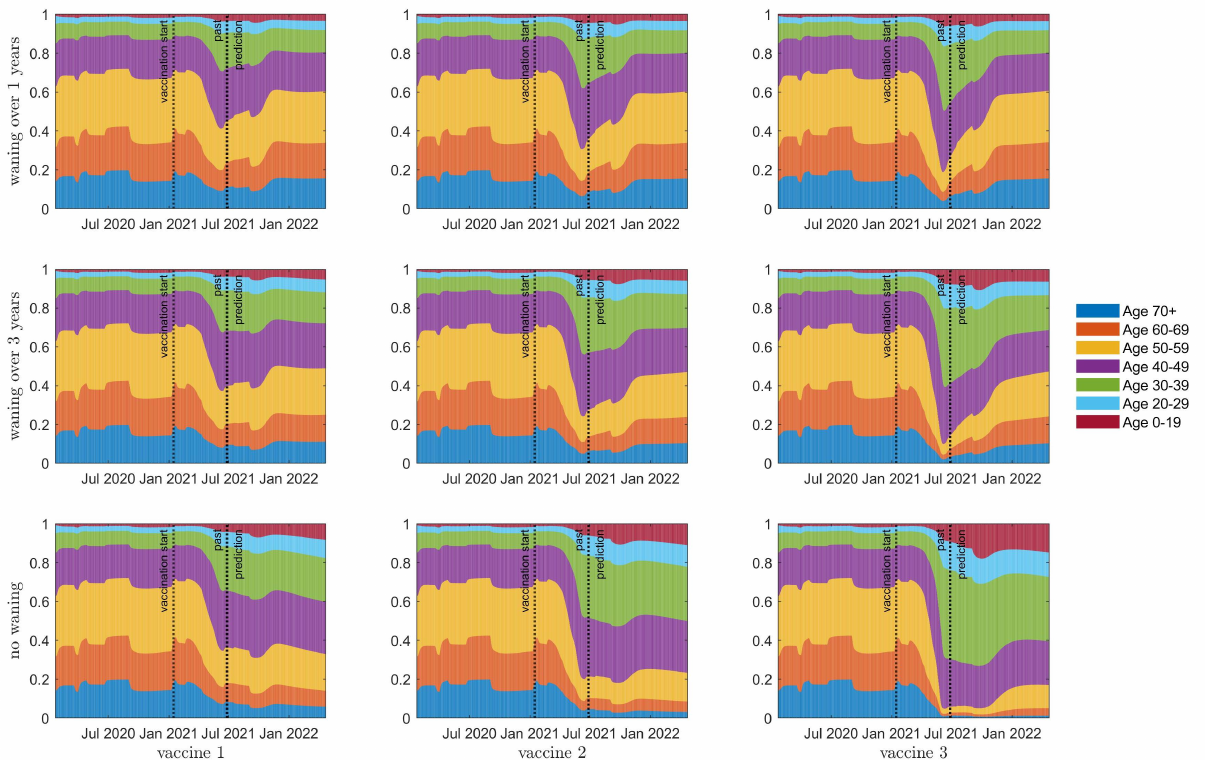
Figure 5. Age structure of daily incidence of severe disease, I 4 , over 7 different age groups (see legend and corresponding colours). The top row is waning of immunity by one year between consecutive classes; the middle row is waning of immunity of three years; the bottom row is no waning of immunity. Columns left to right represent vaccines 1 to 3,